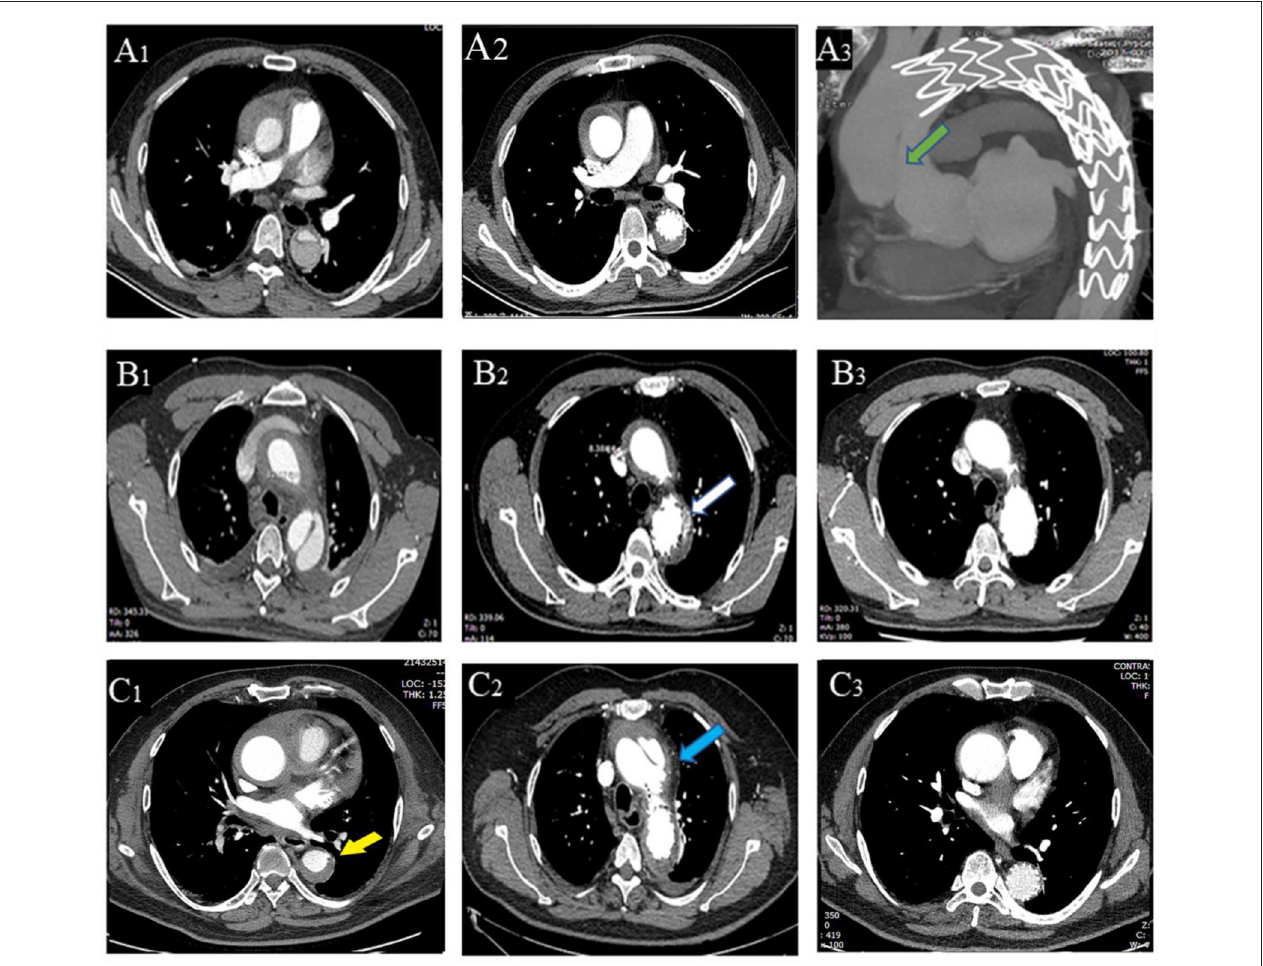
FIGURE 2 | Thoracic endovascular aortic repair (TEVAR)-related complications. A patient with entry tear on admission (A 1 ) , 2 weeks after TEVAR (A 2 ) , and had type A aortic dissection 4 months (A 3 ) after TEVAR (new entry tear in ascending aorta, green arrow). (B 1 − 3 ) A patient with entry tear had type I endoleak ( B 2 , white arrow) 2 weeks after TEVAR, which disappeared 6 months later (B 3 ) . A patient with penetrating atherosclerotic ulcer (PAU, yellow arrow, C 1 ) had aortic arch dissection (blue arrow, C 2 ) induced by proximal portion of stent graft with hematoma thickening 2 weeks after TEVAR, and the dissection was confined within the aortic arch with hematoma disappearing (C 3 )